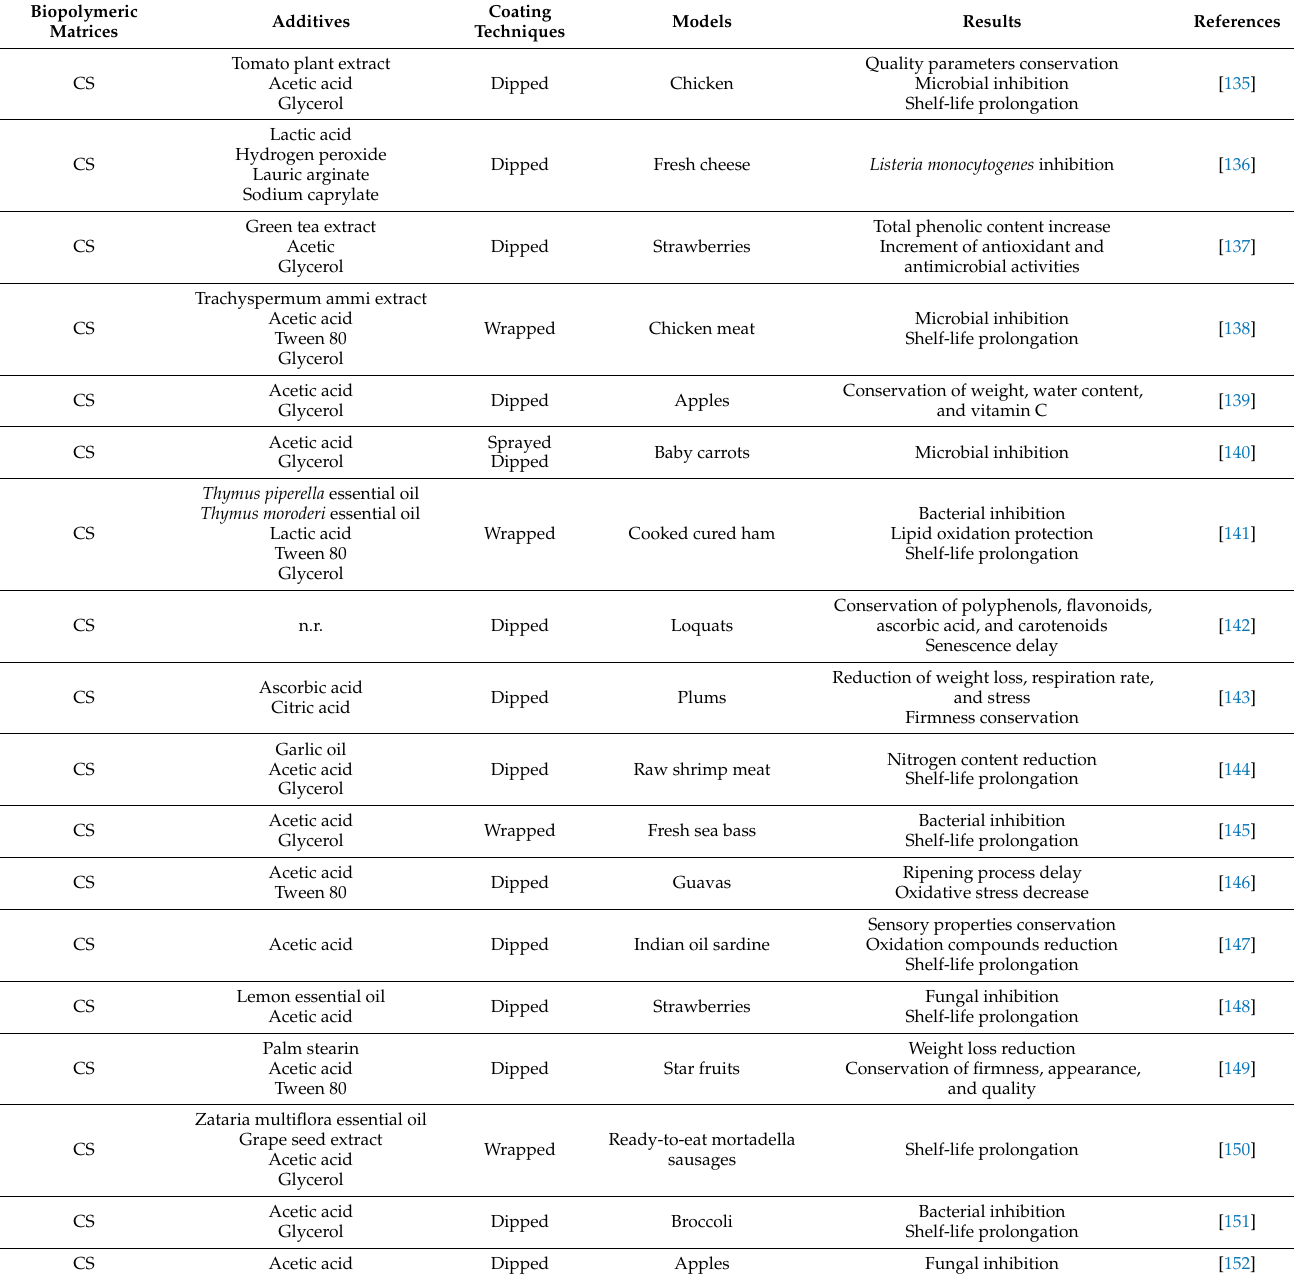
Table 4. Application of chitosan-based edible films and coatings on food